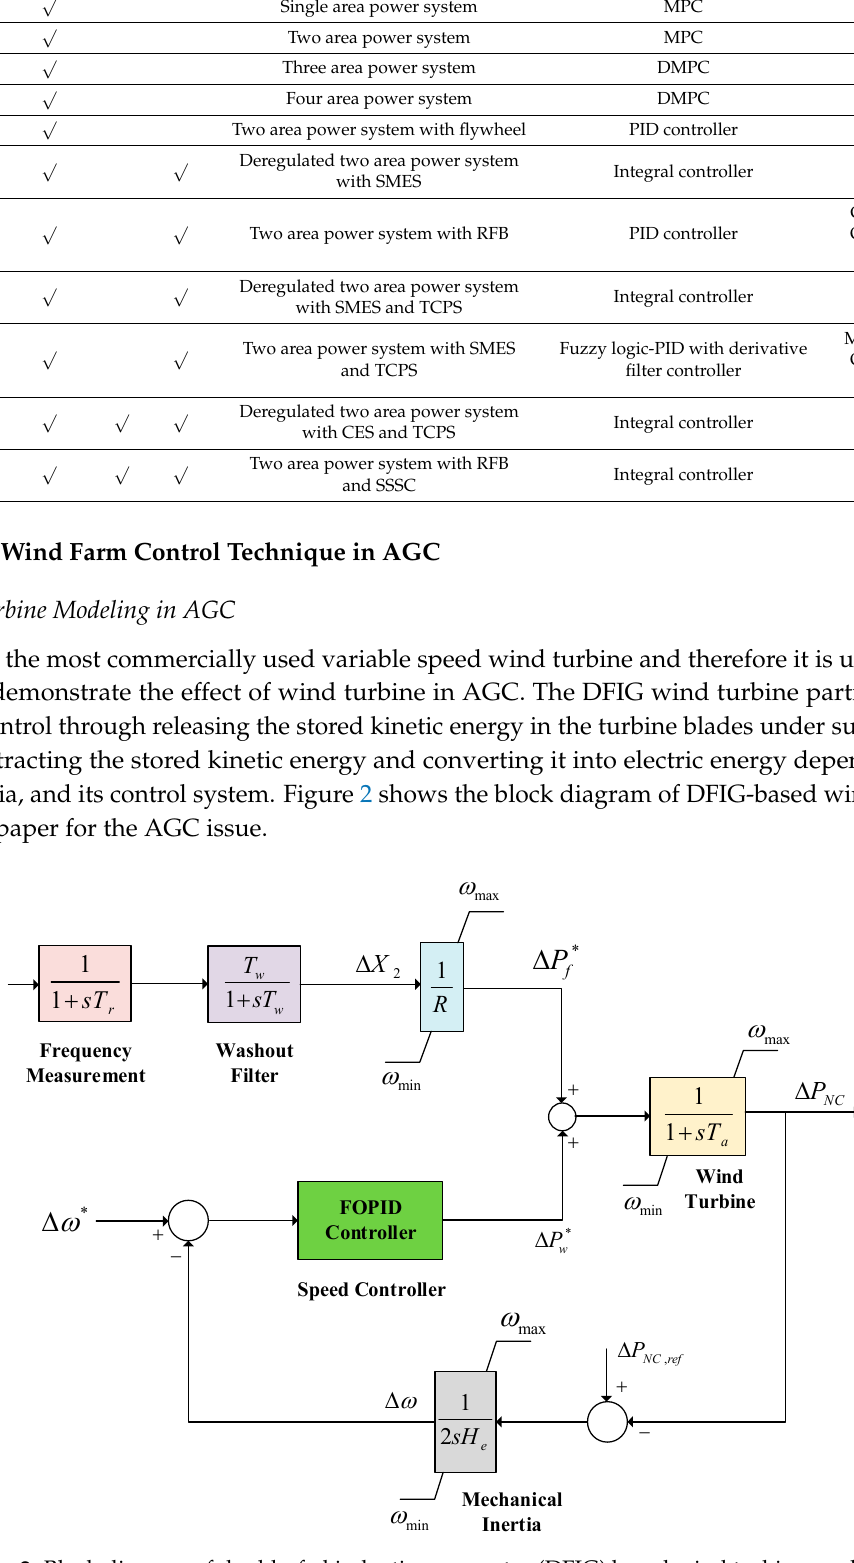
Figure 2. Block diagram of doubly-fed induction generator (DFIG) based wind turbine model. P In this model, the extra signal * f